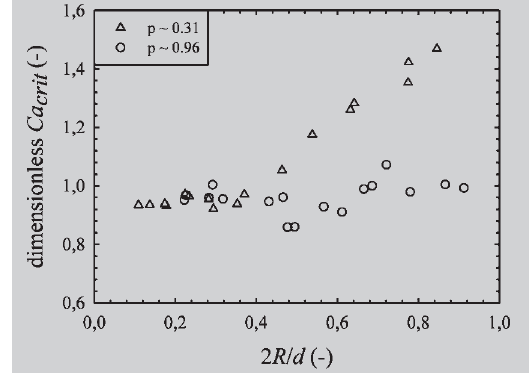
Figure 1 (left): Critical capillary number as a function of degree of con- finement (PDMS in PIB) for two viscosity ratios (adapt- ed from [31]). Figure 2: Droplet-string transition in immiscible sheared polymer blends (28 % PDMS in PIB). Experiments were per- formed using a Linkam par- allel plate shearing cell. The distance between the plates was 36 micrometers. The various pictures were taken in the flow - vorticity plane, respectively at shear rates of a) 6.4 s -1 , b) 4.1 s -1 , c) 2.62 s -1 , d) 2.48 s -1 (adapted from